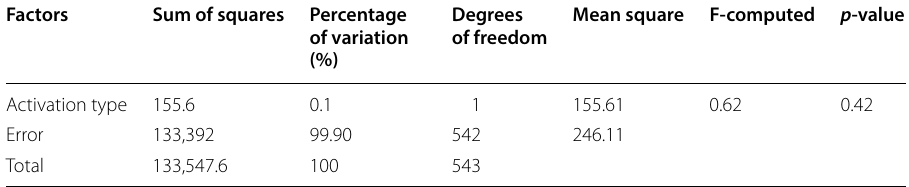
Table 6 One-way ANOVA for type of activation and classification task Factors Sum of squares